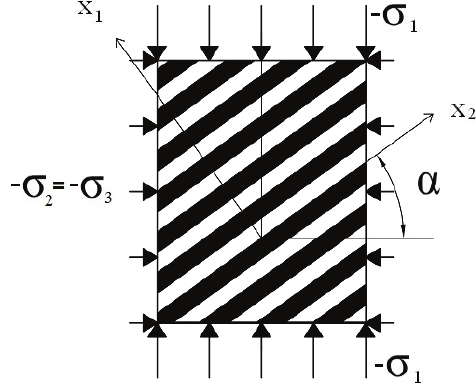
Fig. 2. Principal load direction during the test and orientation angle α